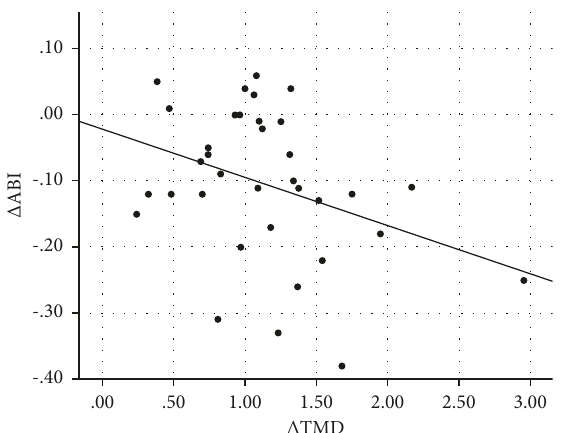
Figure 7: Scatter plot graph of